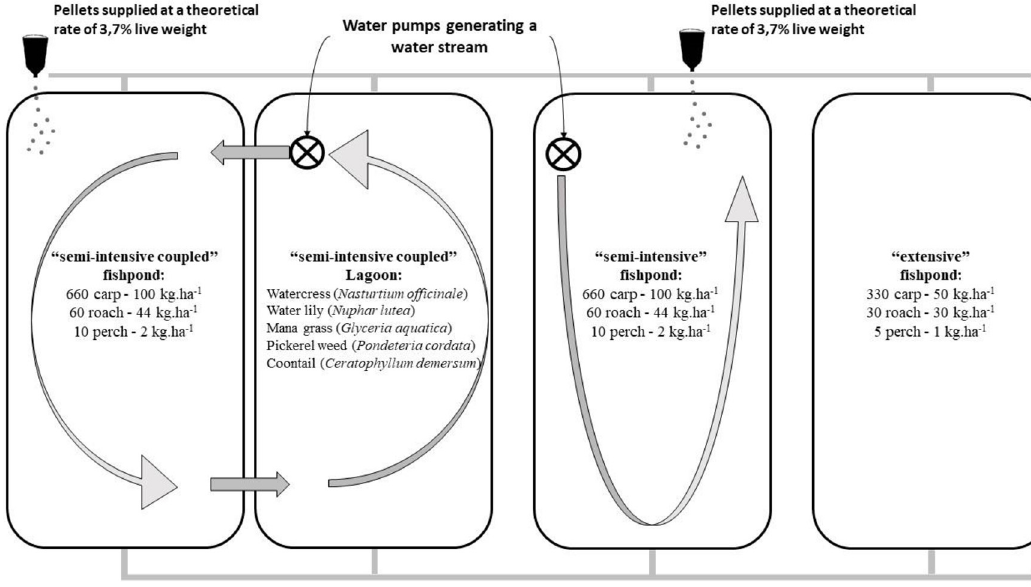
Fig. 1. Diagram of the experimental design with two replicates in each